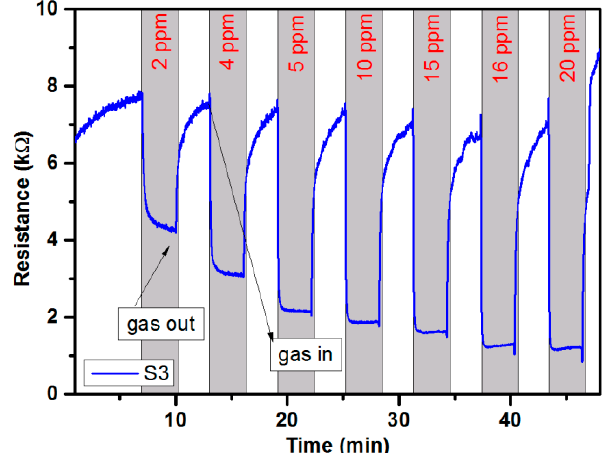
Figure 7. The resistance changes of sensor S3 (non-dedicated to acetone detection) in a gas sensor array under exposure to 2–20 ppm of acetone. Optimal operating temperature (given by the manufacturer) was ensured and 50% relative humidity was stabilized.